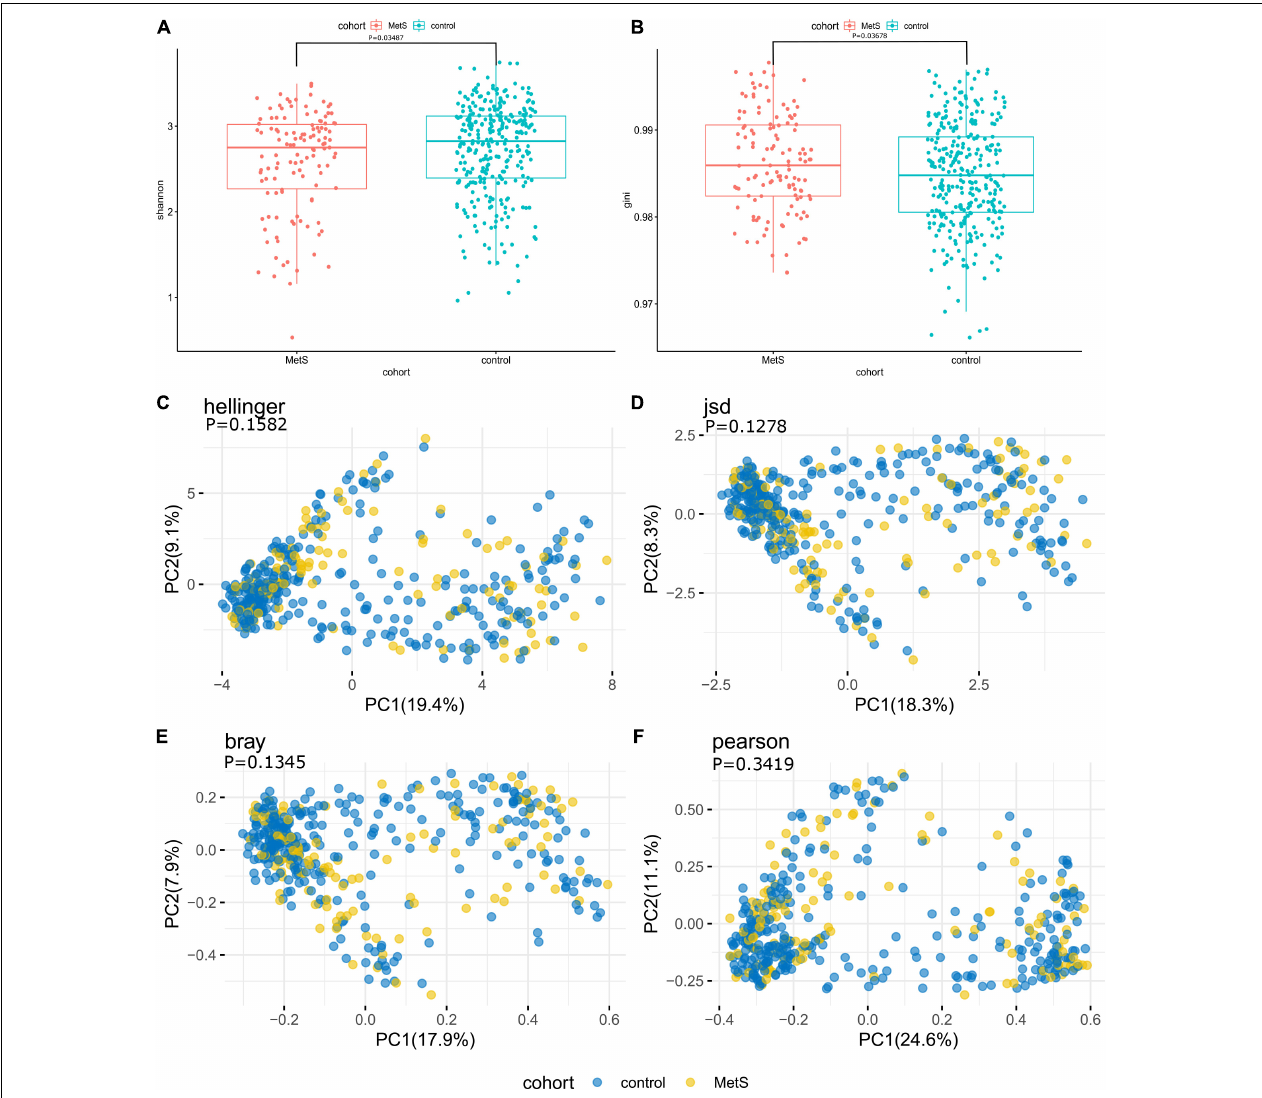
FIGURE 2 | Alpha diversity, beta diversity, and bacterial profiles of feces. (A,B) Alpha diversity was measured by both Shannon index and Gini index for comparisons between the MetS and control groups. The MetS subject microbiomes had significantly lower species-level alpha diversity compared to the microbiomes of the control group ( p = 0.03487 and p = 0.03678). (C–F) Beta diversity between the MetS group and control group. Beta diversity was calculated based on the Hellinger distance, JSD distance, Bray distance, and Spearman distance, and no significant differences were found between the MetS and control